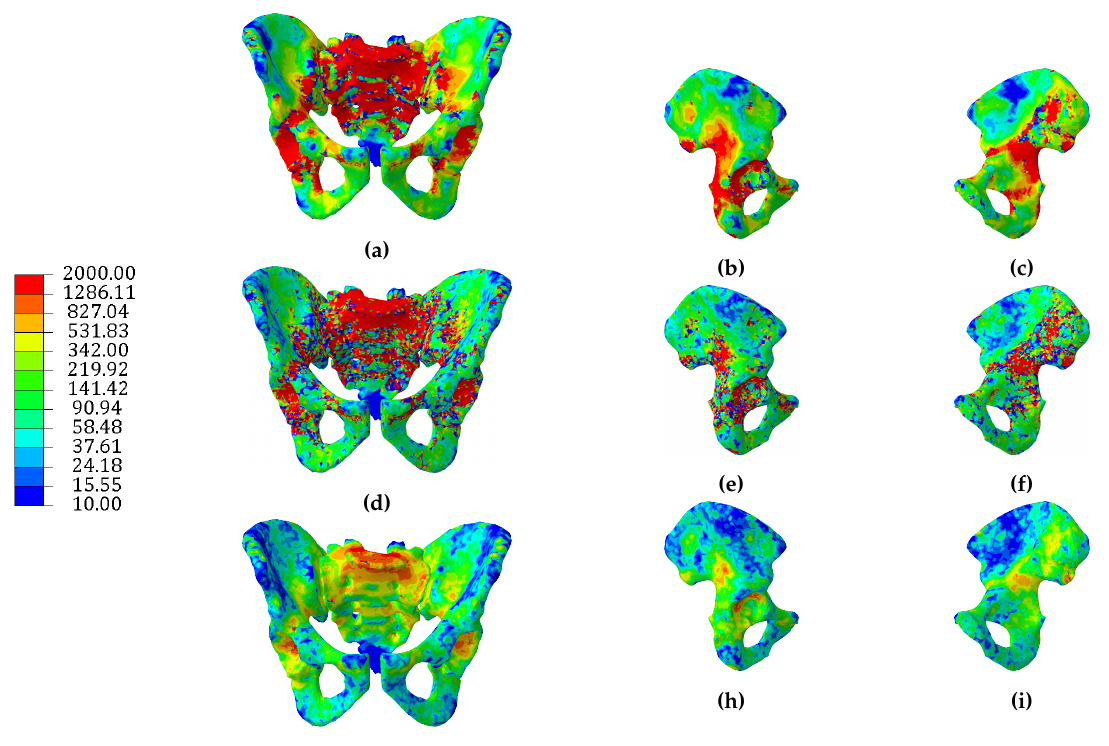
Figure 5. Distributions of trabecular Young’s modulus (MPa) for the hybrid isotropic model ( a – c ), dominant Young’s modulus ( d – f ) and mean Young’s modulus ( g – i ) for the hybrid orthotropic